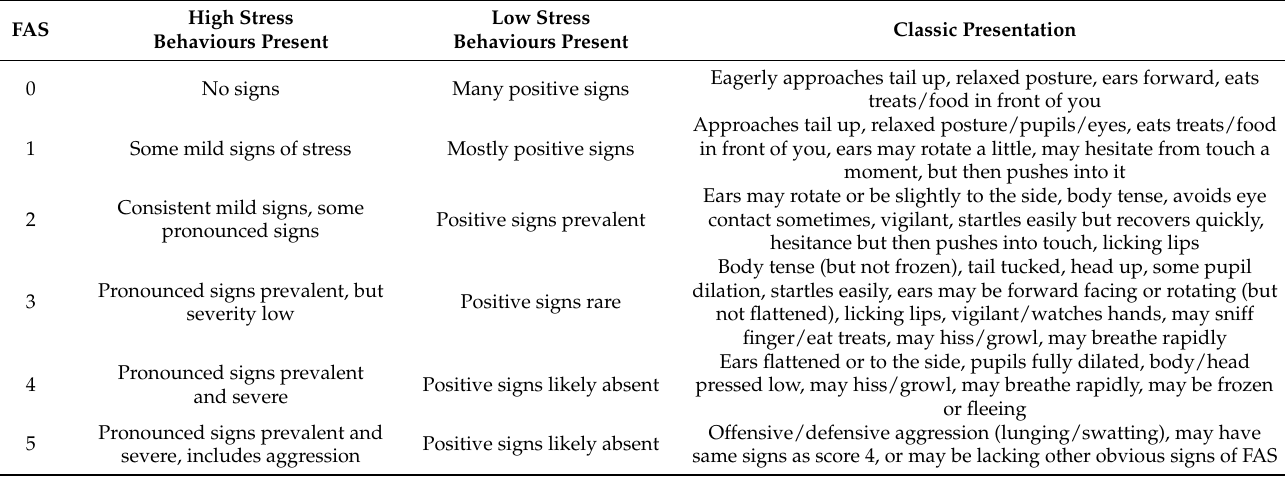
Table 1. Differentiation between adapted FAS categories.